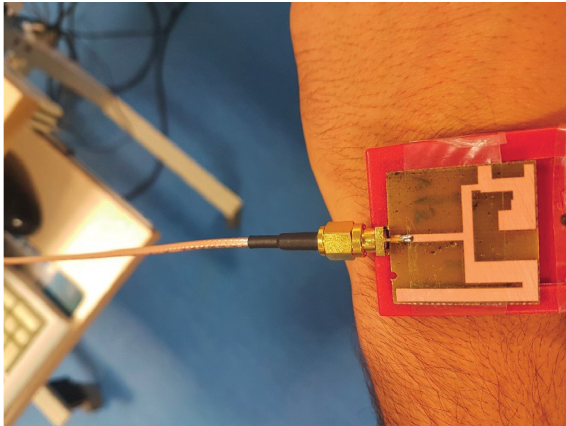
Figure 13: Smartwatch case used for S11